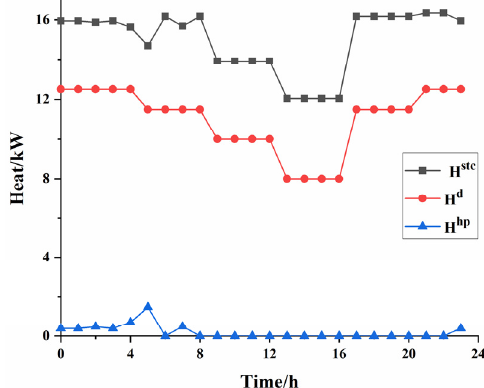
Figure 9. Heat output of the solar thermal energy collection field module, the heat pump, and the SA-CAES.